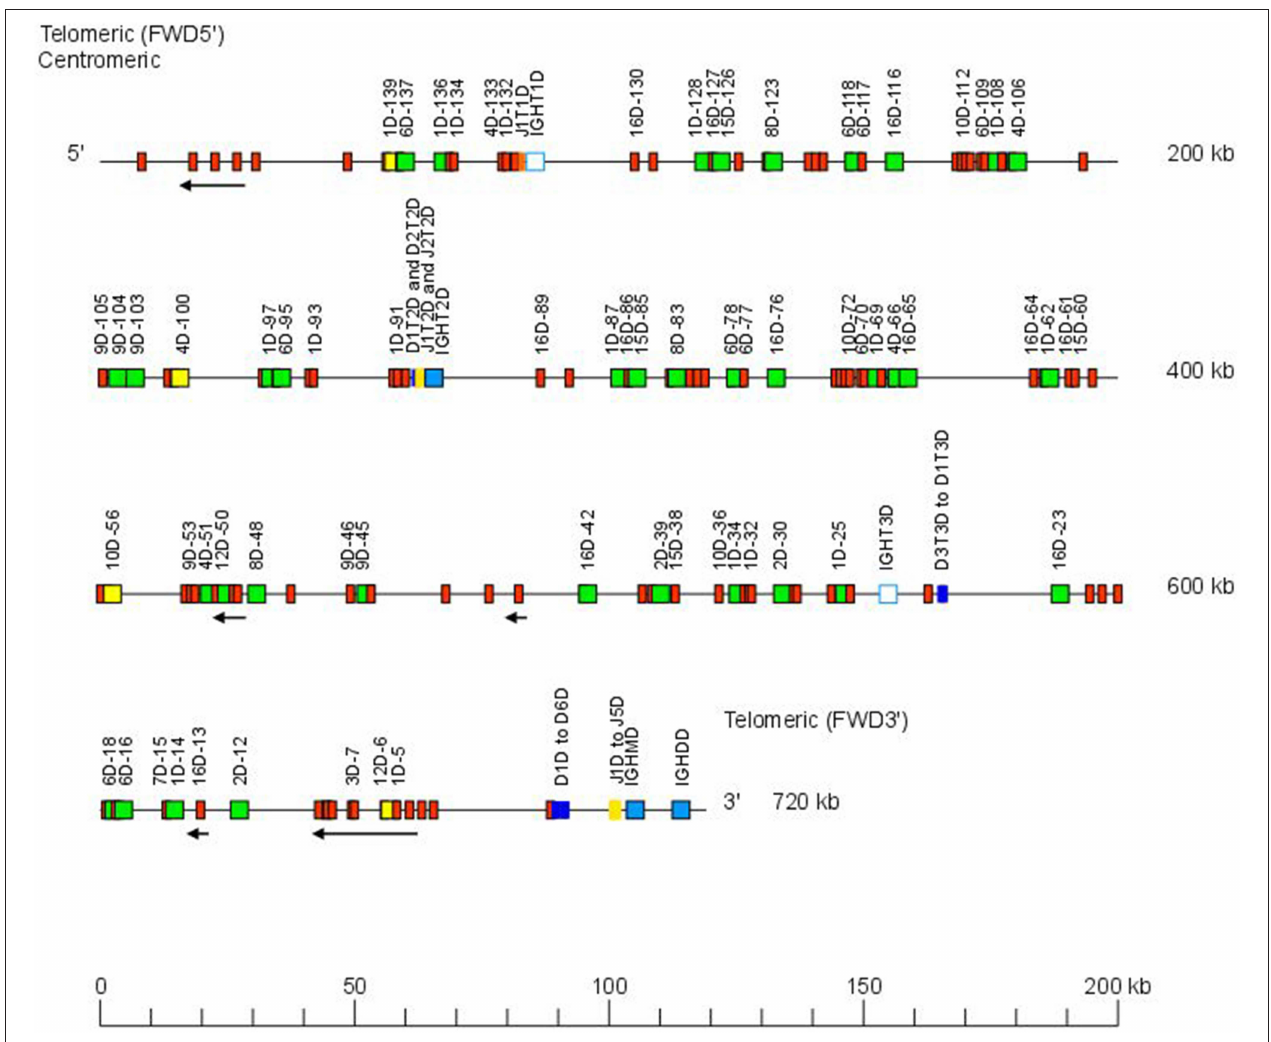
FIGURE 2 | Organization of the Atlantic salmon ( S. salar ) locus B. The orientation of the Atlantic salmon ( S. salar ) IGH locus on chromosome 3 (locus B—Salsal ssa03) is forward (FWD). IGH gene names are according to IMGT nomenclature (3). Single arrows show genes whose polarity is opposite to that of the D-J-C CLUSTER comprising IGHD (D1–D9)-IGHJ (J1–J5)-IGHM-IGHD. Gene names of IGHV pseudogenes with frameshift(s) in the V-REGION are not displayed due to lack of space in the locus map at the IMGT standardized scale (line = 200kb). All gene names are displayed in a zoom (line = 100kb) on the IMGT site [IMGT Repertoire (IG and TR) > Locus and genes > Locus representations] 1 . Color coding of genes is according to the IMGT Color menu for genes (IMGT Scientific chart > 4. Representation Rules > IMGT color menu > 11. Color menu for genes) 1 : V-GENE (green: functional, yellow: ORF, red: pseudogene), D-GENE (blue: functional), J-GENE (yellow: functional), and C-GENE (blue: functional, white box: pseudogene). With permission of IMGT ® , the international ImMunoGenetics information system ®